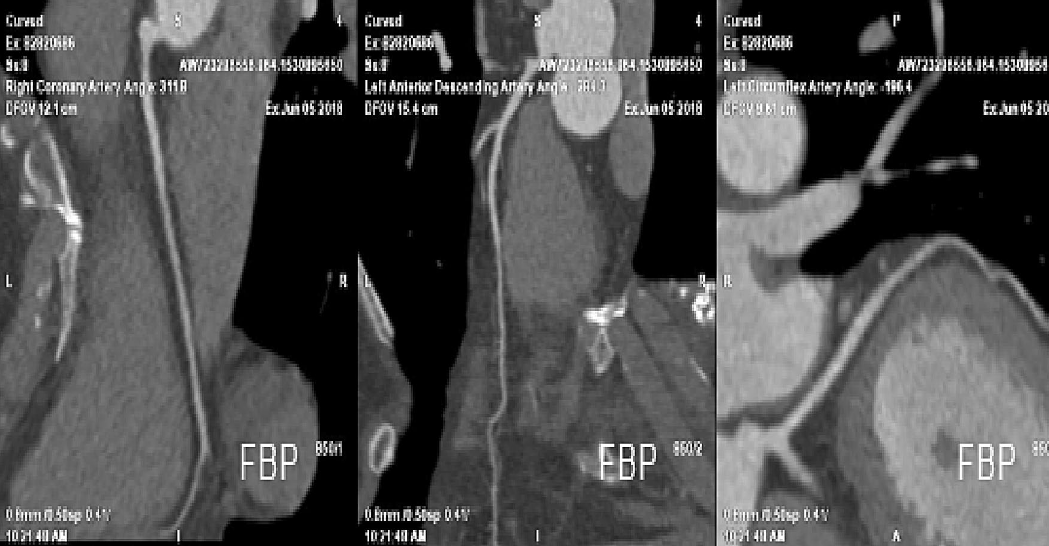
Figure 2. Representative image of a 70-year-old female patient, body surface area (BSA) 1.58 m 2 , body mass index (BMI) 27.27 kg/m 2 , heart rate (HR) 96 bpm, obtained using 40 mL contrast agent injected at a flow rate of 3.5 mL/s on a Flash computed tomography scanner.